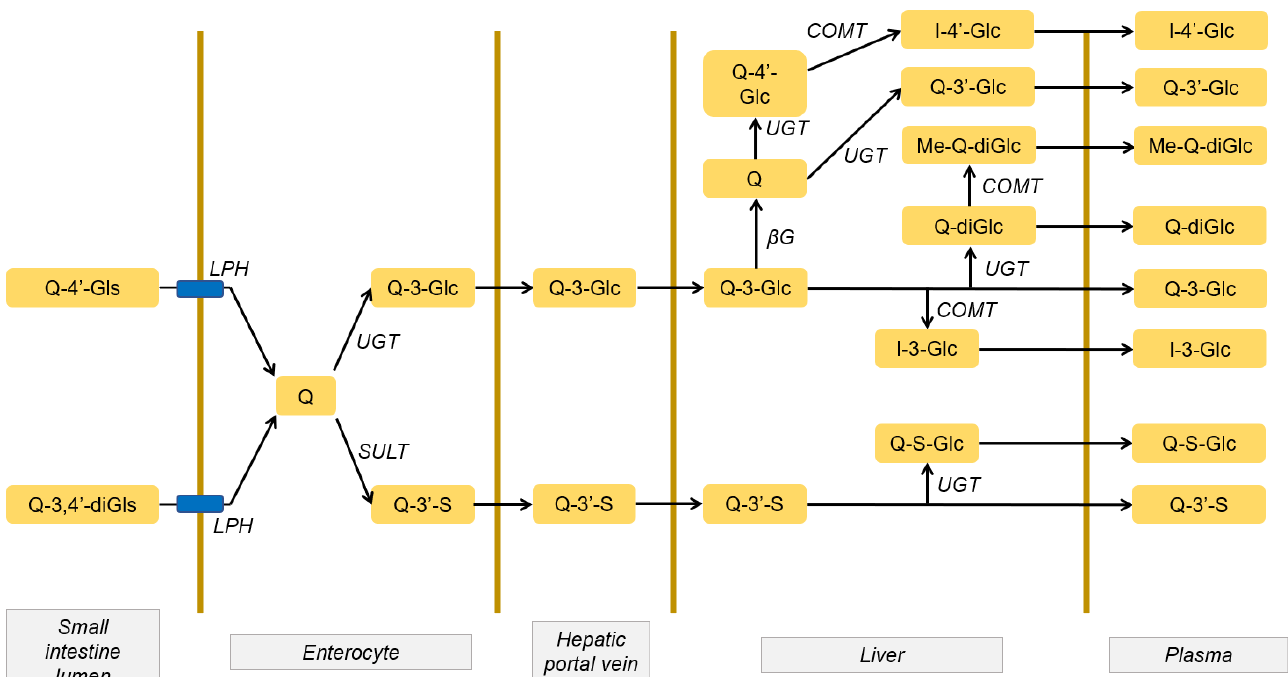
Figure 1. Metabolism of quercetin glycosides as they pass through the body. Quercetin glycosides are metabolized on their way through the enterocyte, and the metabolites are transported to the liver through the portal vein. Subsequently, metabolites quercetin 3-O-glucuronide and quercetin 3-O-sulfate undergo a second transformation in the liver before returning to the bloodstream. Modified figure from [20], adapted with permission from British Journal of Nutrition. Gls: glycoside, diGls: diglycoside, Glc: glucuronide, Q: quercetin, S: sulfate, SULT: sulfotransferase, UGT: glucuronyltransferase, GT: glucosyltransferase, I: isorhamnetin, COMT: methyltransferase, LPH: lactase-florizin hydrolase.